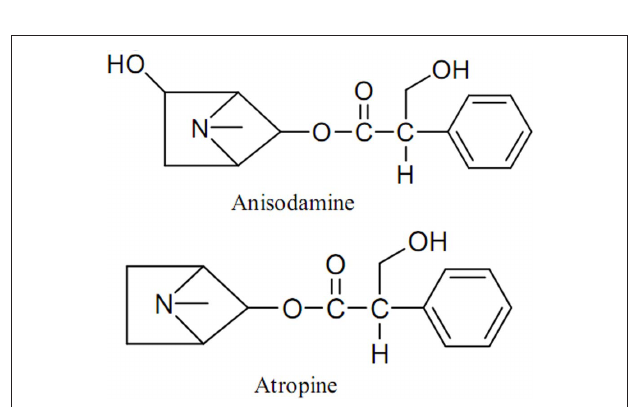
FiguRe 3 | Action mode of anisodamine in cholinergic anti-inflammatory